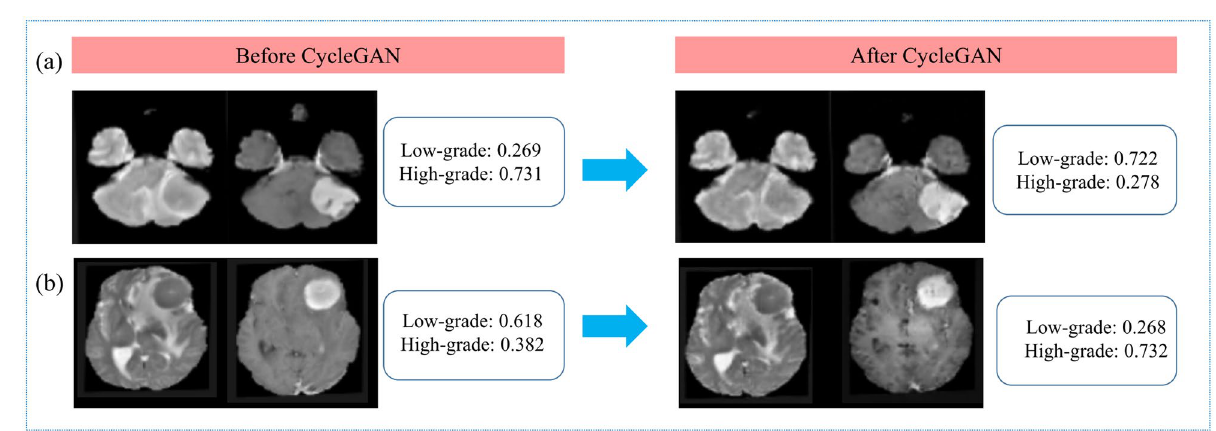
Figure 4. Representative cases showing the improvement in classifications after CycleGAN. Predictive scores close to 1.0 indicate that the model predicts the meningioma grade with confidence. ( a ) A case incorrectly diagnosed as high-grade meningioma before style transfer but correctly diagnosed as low-grade meningioma after style transfer. ( b ) A case incorrectly diagnosed as low-grade meningioma before style transfer but correctly diagnosed as high-grade meningioma after style transfer. CycleGAN = Cycle-Consistent Adversarial